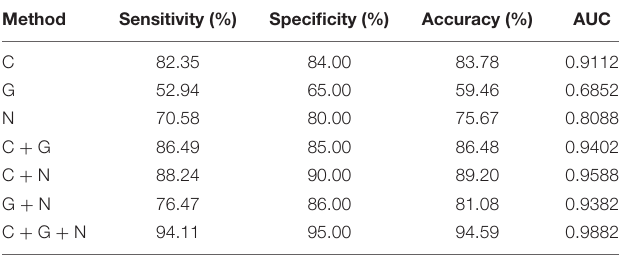
TABLE 11 | Classification performance corresponding to different